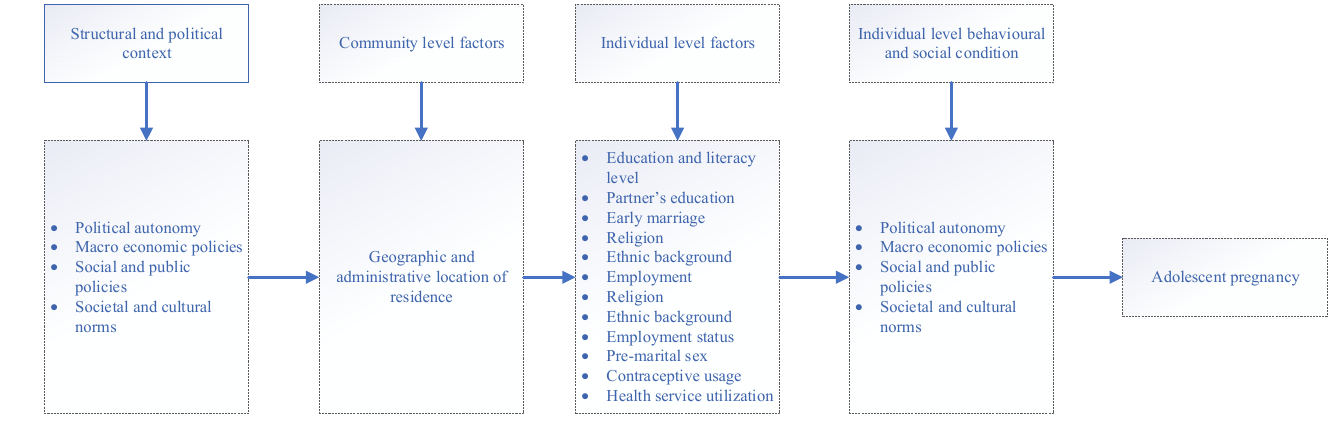
Figure 1. Conceptual framework for social determinants of adolescent pregnancy.